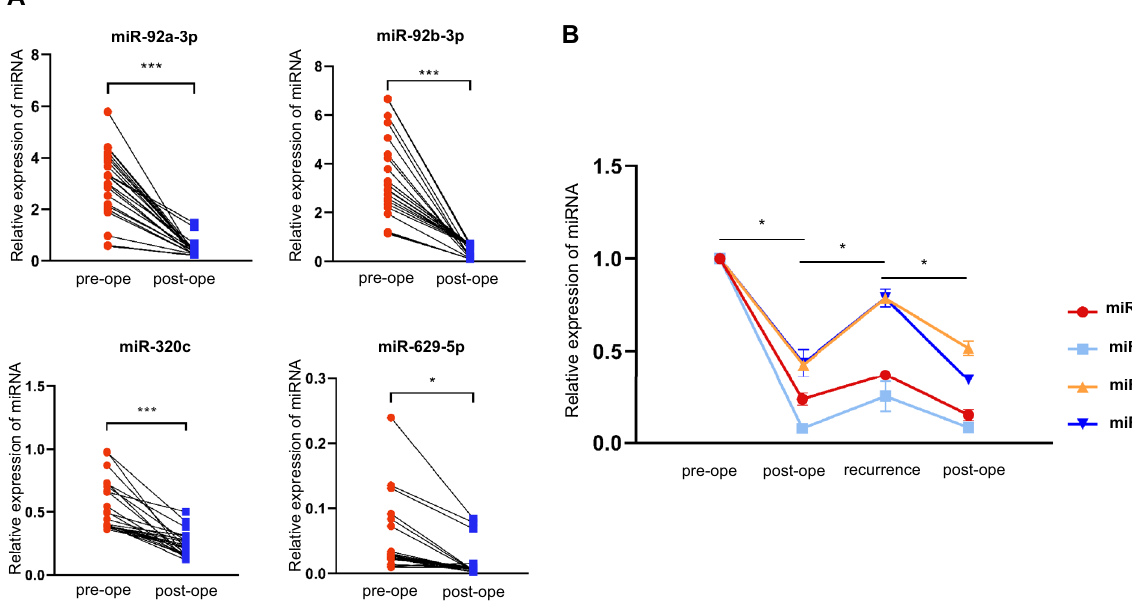
Figure 4. Circulating levels of the 4 miRNAs contribute to the monitoring of tumor treatment responses. ( A ) Serum expression of candidate miRNAs in patients with oral squamous cell carcinoma (OSCC) (n = 8) before and after surgical removal of the primary tumor. ( B ) Four miRNAs follow the process in a patient with OSCC recurrence. All p values were determined by the paired t